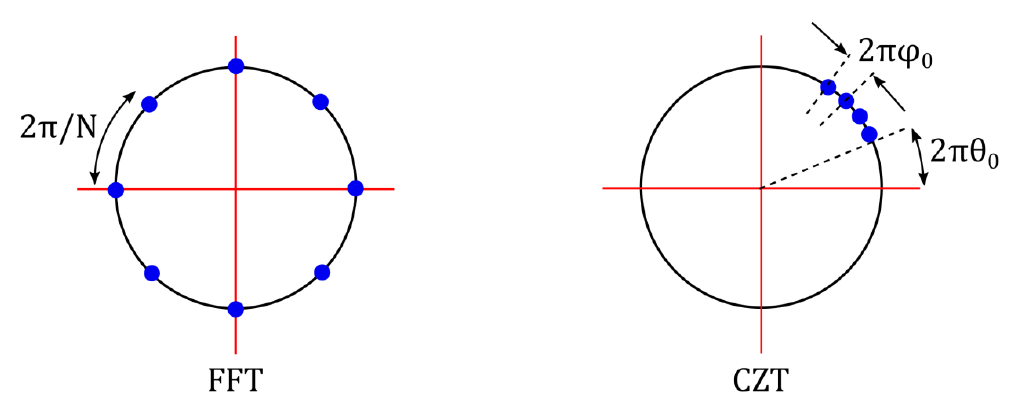
Figure 2. Z-plane unit circle representation of the fast Fourier transform (FFT) and the chirp z transform (CZT).